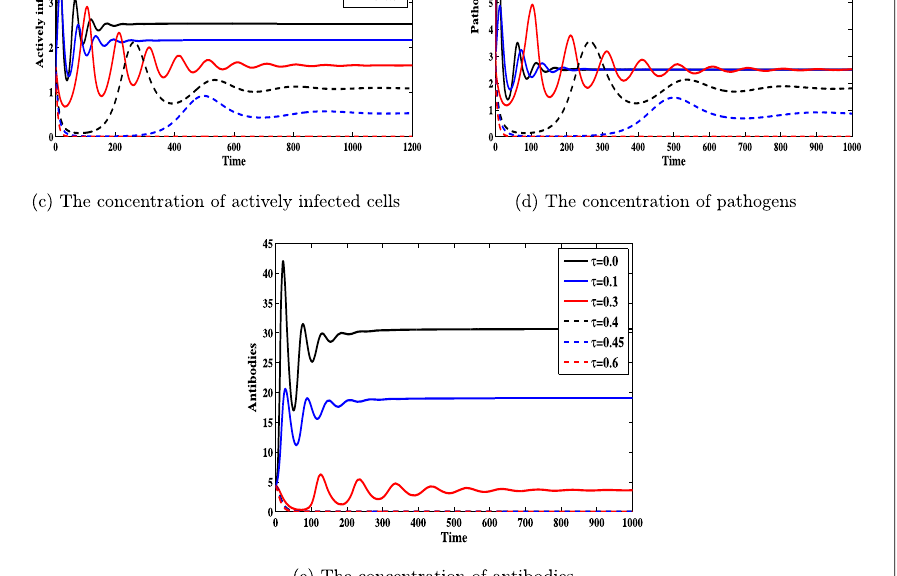
We have investigated the global stability of all steady states of the model by using Lya- punov method and LaSalle’s invariance principle. We have proven that (i) if R 0 ≤ 1, then the pathogen-free steady state (cid:16) 0 is globally asymptotically stable; (ii) if R 1 ≤ 1 < R 0 , then the infected steady state without antibodies (cid:16) 1 is globally asymptotically stable; and (iii) if R (cid:16) 1 > 1, then the infected steady state with antibodies 2 is globally asymptotically stable. We have conducted numerical simulations and have shown that both the theoretical and numerical results are